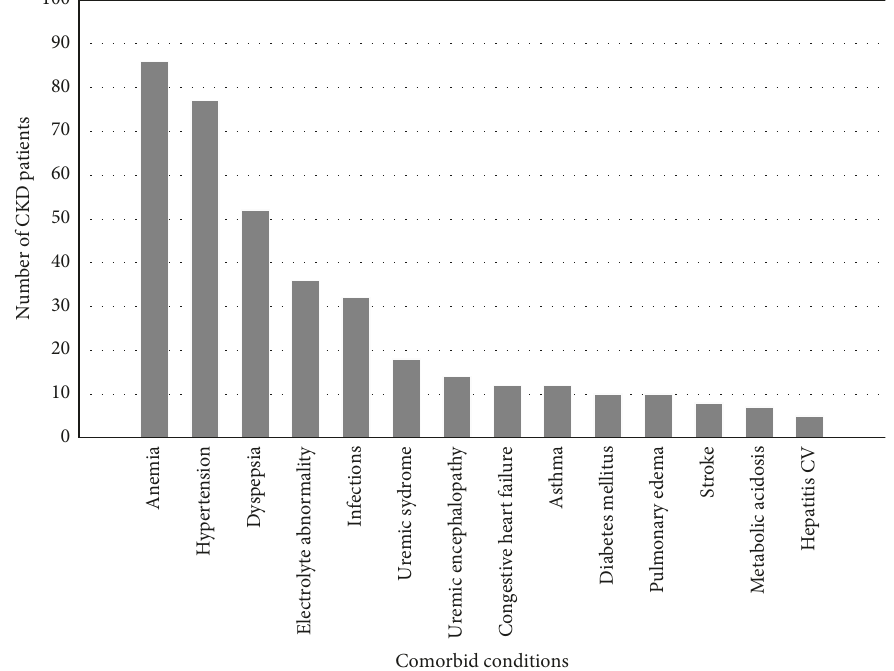
Figure 1: Common comorbidities among study participants at JUMC, Jimma Zone, Jimma, Southwest Ethiopia, from April to September 2018. Table 3: Prevalence of MRPs and their causes among CKD patients at JUMC, Jimma Zone, Jimma, Southwest Ethiopia, from April 1 to September 30,